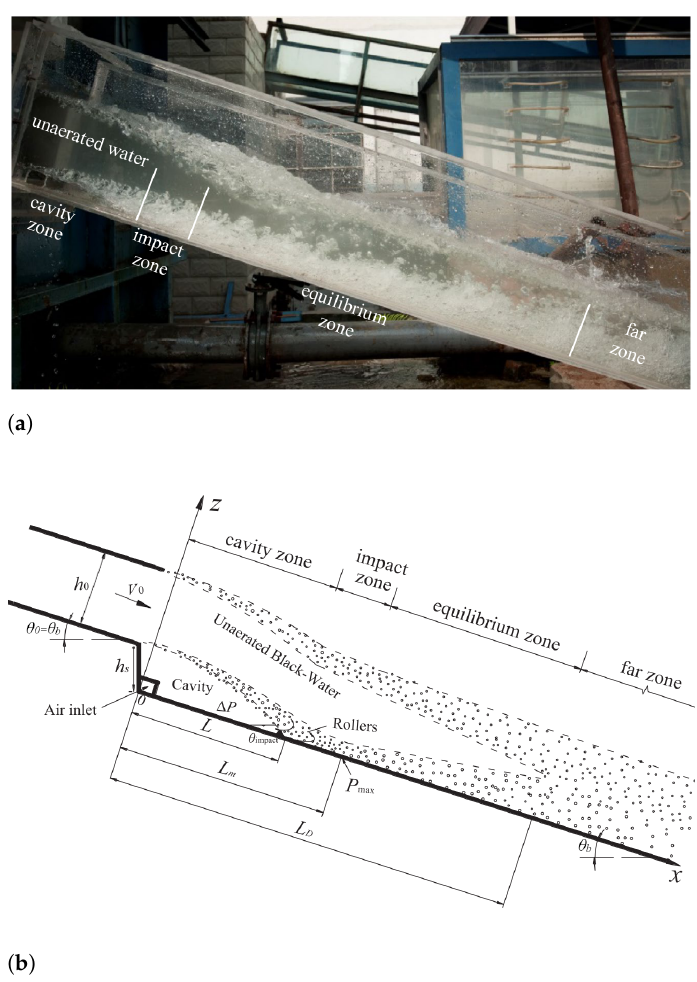
Figure 1. Laboratory setup ([45]-authorized reproduction). ( a ) Physical model (unknown flow conditions). ( b ) Flow